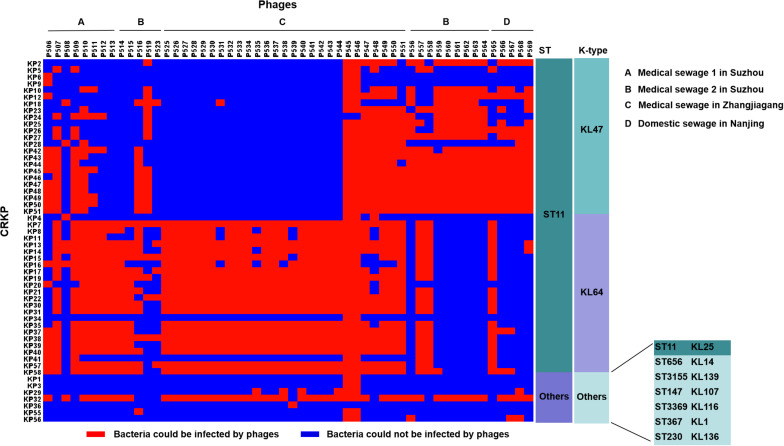
The host ranges of 54 phages. The host range was determined using 54 clinical CRKP isolates. Blue squares represent the CRKP strains (left) that cannot be infected by the corresponding phages (top). Red squares represent the CRKP strains that could be infected by corresponding phages. (A–D) represent different sources of sewage. (A–C) were from hospital and (D) was from domestic sewage wastewater.